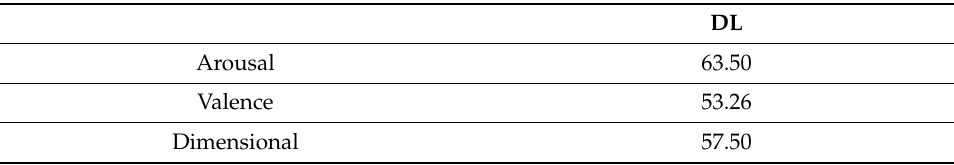
Table 8. DL model’s performance for ECG.